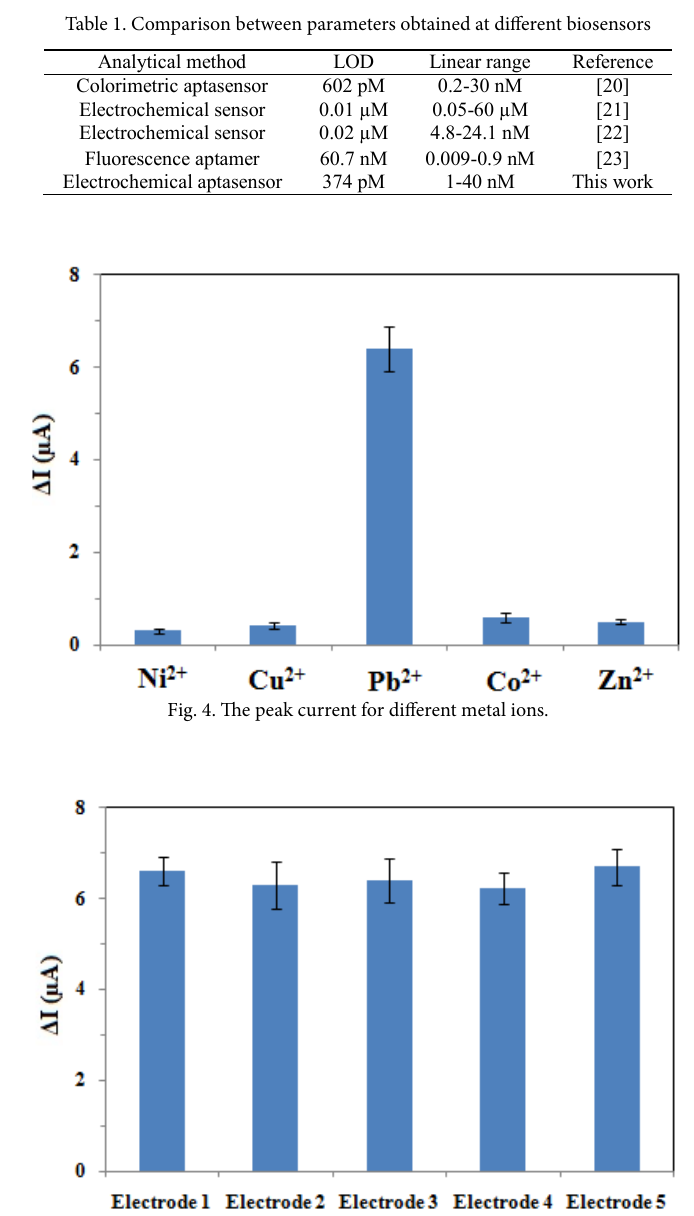
Fig. 5. Peak currents of five electrodes in same Figure 5. Peak currents of five electrodes in same conditions.